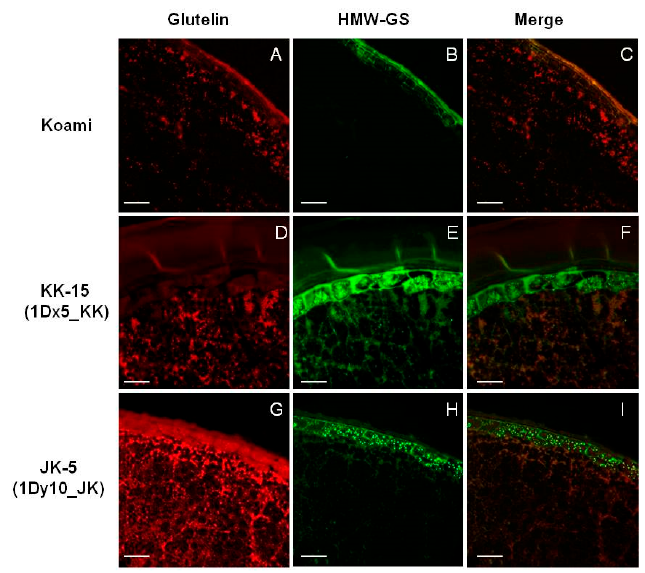
Figure 5. Immunofluorescence localization of glutelins and wheat high-molecular-weight glutenin subunits (HMW-GSs) in wild-type rice seeds of Koami ( A – C ) and transgenic rice lines KK-15 overexpressing 1Dx5_KK ( D – F ) and JK-5 overexpressing 1Dy10_JK ( G – I ). Fluorescence images were generated using red anti-glutelin antibodies ( A , D , G ) and green anti-HMW-GSs antibodies ( B , E , H ), which were then merged ( C , F , I ). White Scale bar: 100 μ m.